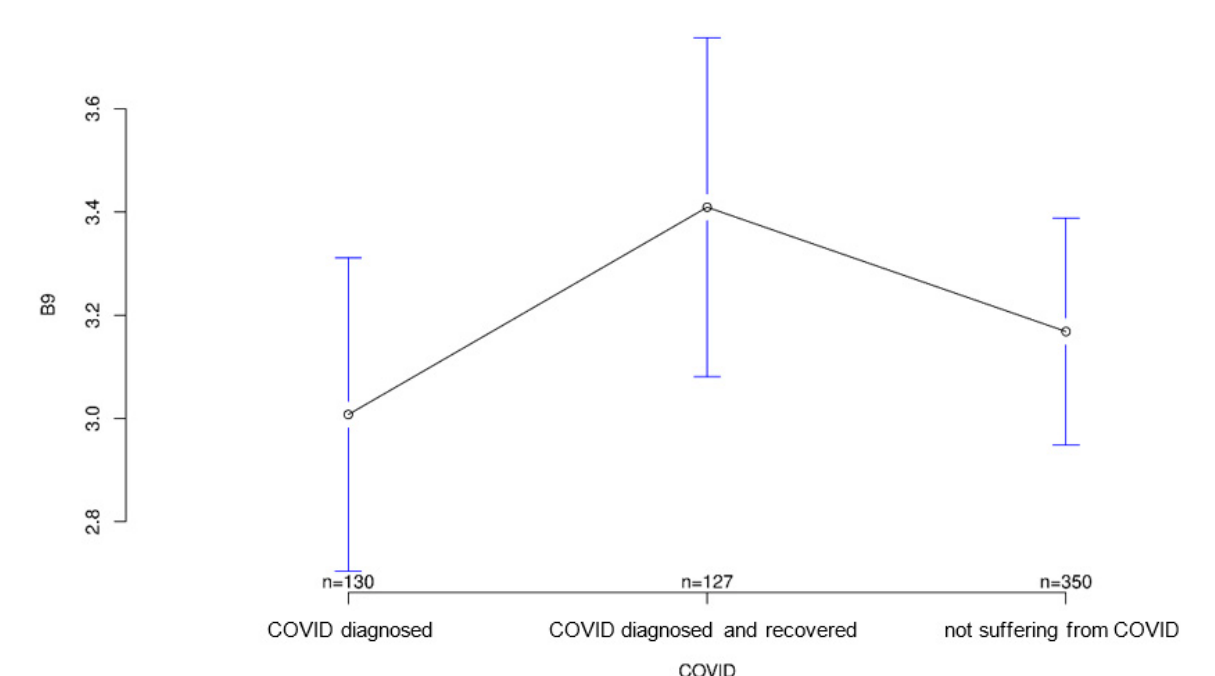
Figure 11. Average agreement with statement 9 of the COVID-specific questionnaire: “If health insurance companies do not cover the entire cost of such sensor technology, the cost should be offset by private co-payments.” The y -axis shows the mean result of participants choice on the Likert scale.